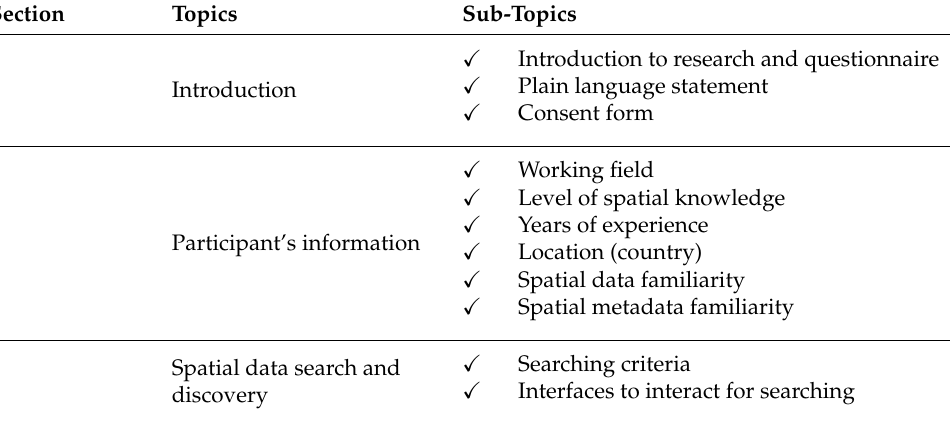
Table 1. Structure of the research questionnaire regarding the user needs and expectations for spatial